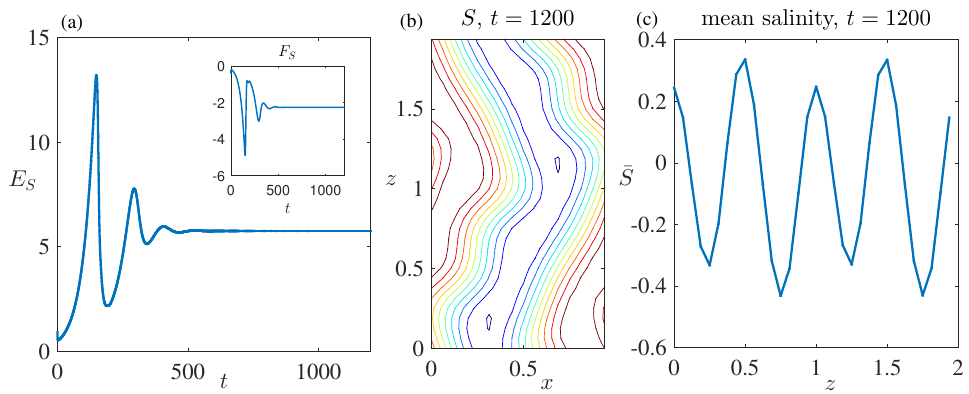
Figure A1. Results from a (cid:96) opt × 2 (cid:96) opt simulation for Ra = 1.1. ( a ) Evolution of the total energy and the vertical salinity flux with time; ( b ) large-time salinity field; ( c ) associated horizontal mean salinity. Distances are measured in units of the wavelength of the optimal mode.